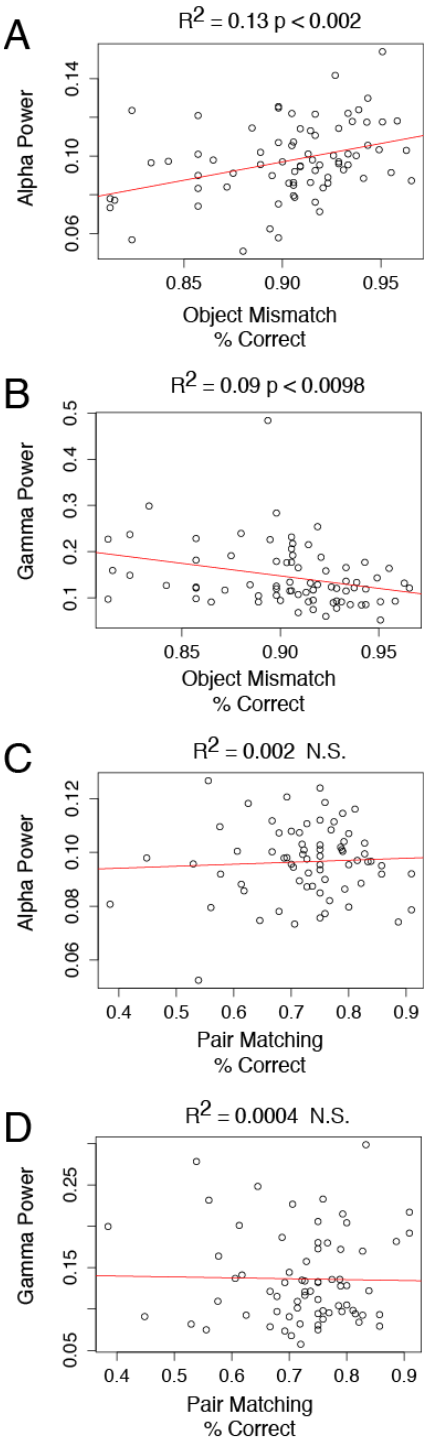
Figure 4. Alpha and gamma power varied with performance on a focal attention-intensive game, but not a memory- intensive game. (A) Alpha power increased with percent correct in the Object Mismatch game. (B) Gamma decreased with performance on Object Mismatch. (C, D) Alpha and gamma were not correlated with performance on the Pair Matching